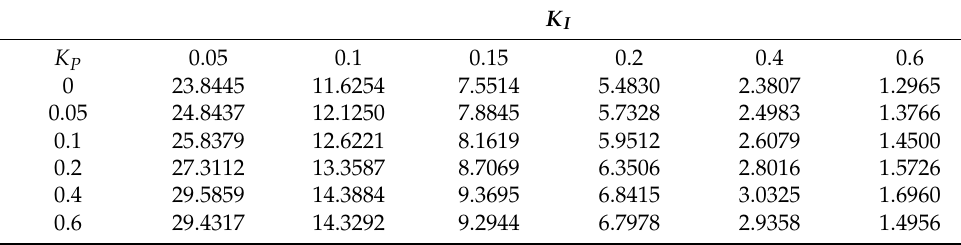
Table 12. Delay margin (two-area LFC system, G m = 1, φ m = 20 ◦